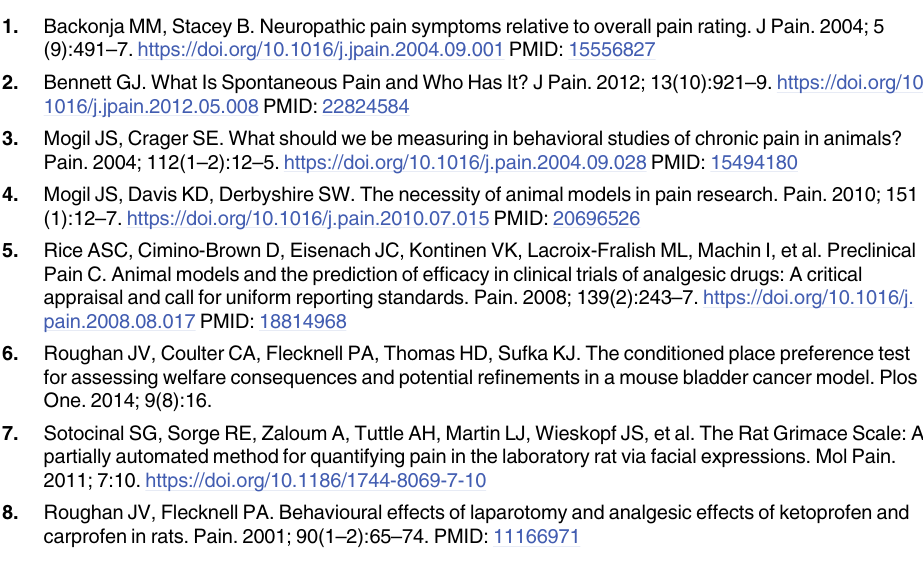
S1 Table. Between strain comparisons of RGS and CBS scores of Sprague-Dawley and Wis- tar rats within treatment groups. Sprague-Dawley: saline: n = 11, meloxicam: n = 8, bupre- norphine: n = 7; Wistar: saline: n = 10, meloxicam: n = 8, buprenorphine: n = 8. p values and 95% confidence intervals of the differences are reported for each